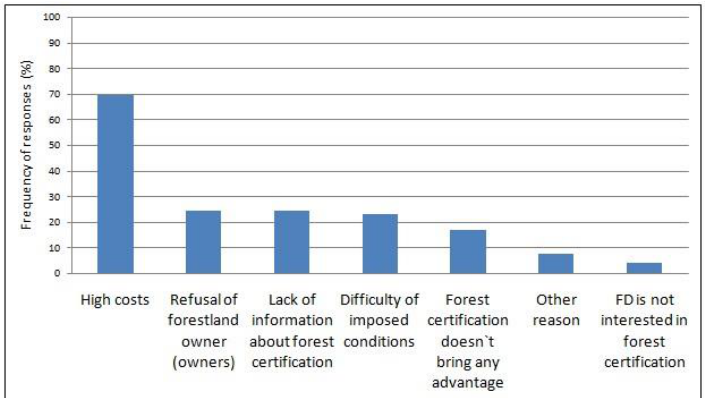
Figure 3. Reasons for not adopting FSC certification—the case of non-state Forest Districts (Multiple choice question (in Supplementary): What were the reasons for not certifying the FD?)